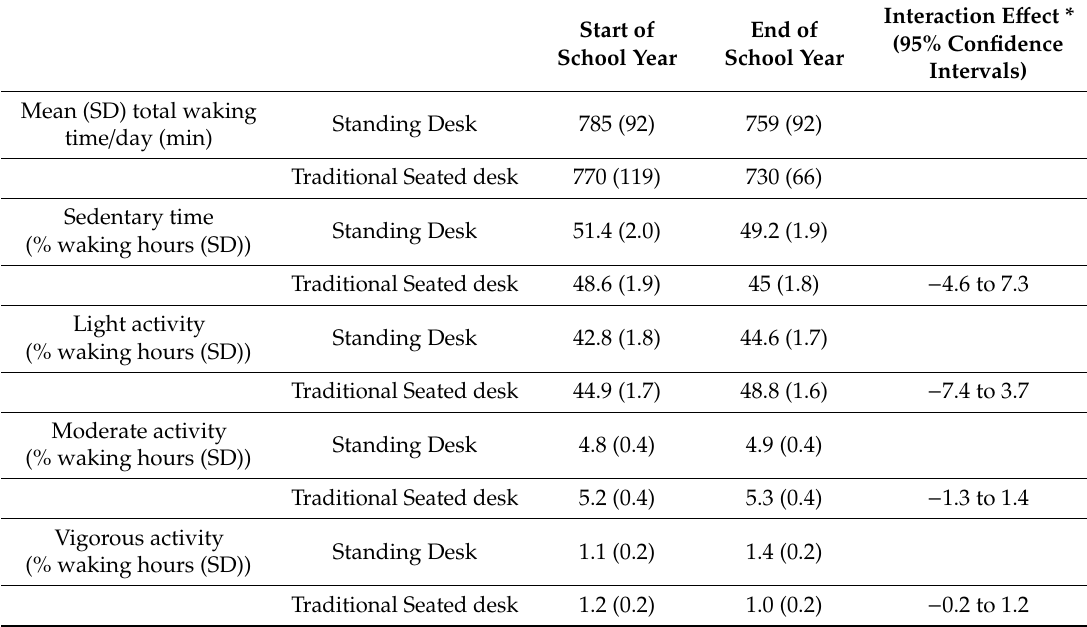
Table 1. Comparison of mean (SD) percentage of sedentary time and light, moderate, and vigorous physical activity between the standing desk and traditional seated desk conditions and over time (start of the school year and end of the school